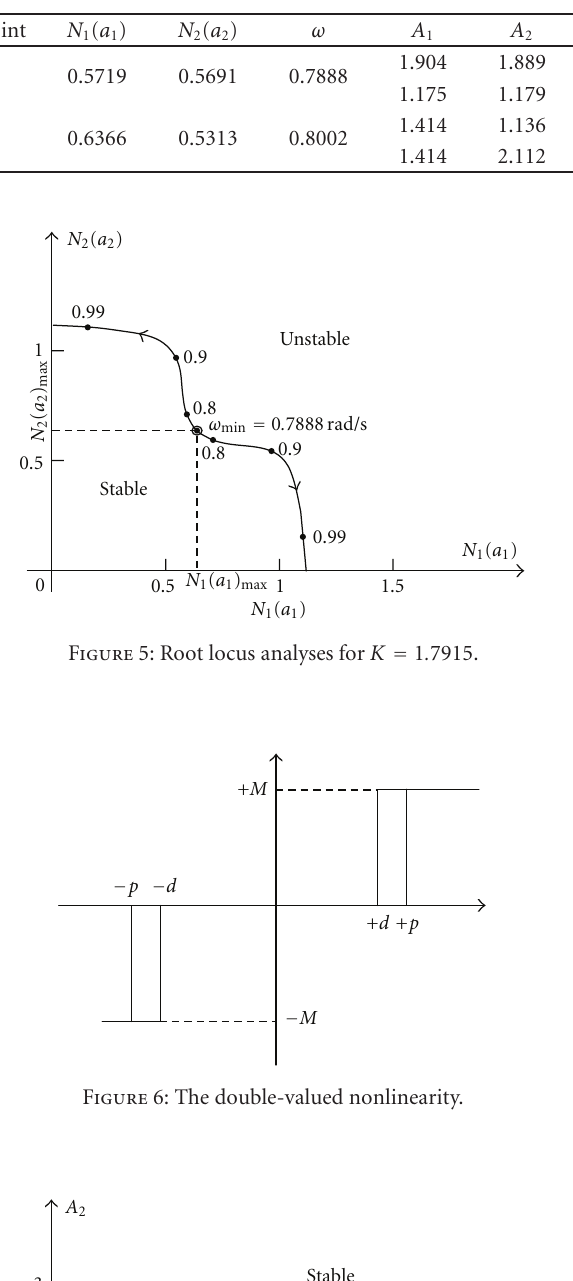
Table 1: Calculated results of a stable (Point Q 1 ) and a unstable limit cycle (Point Q 3 ).